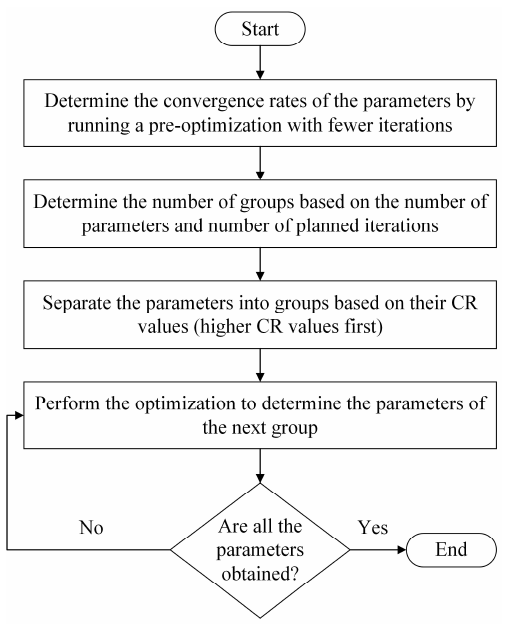
Figure 6. Flow chart of the multi-step optimization.